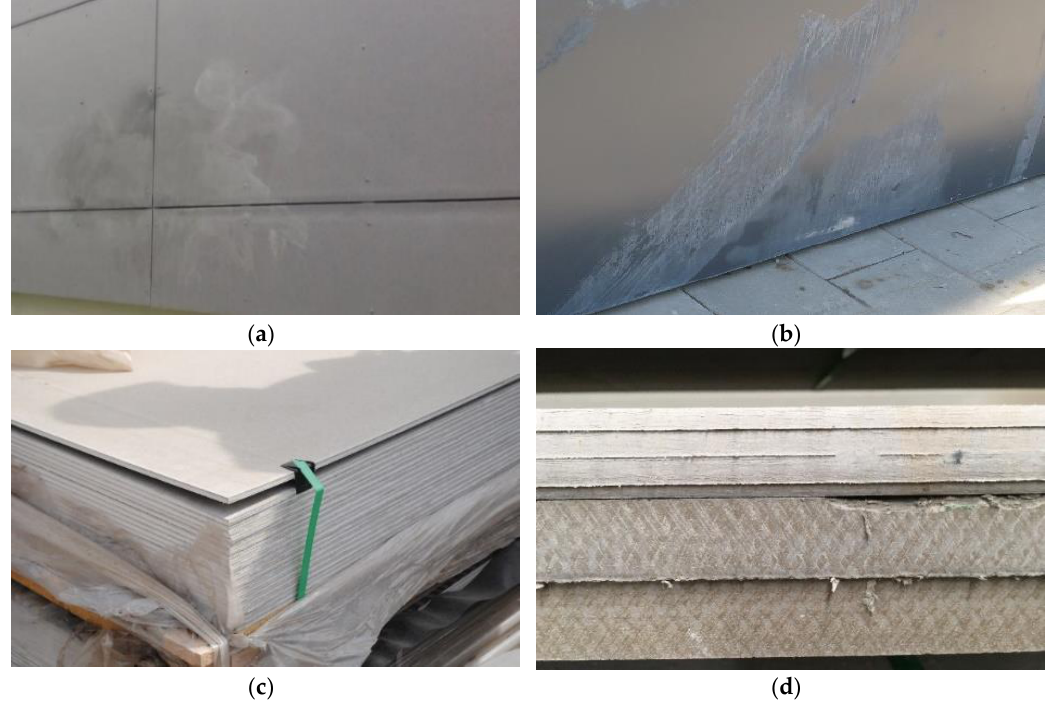
Figure 14. Damaged building façades made of fiber cement boards ( a ), ( b ) and warped stock boards containing recycled materials ( c ), ( d ).